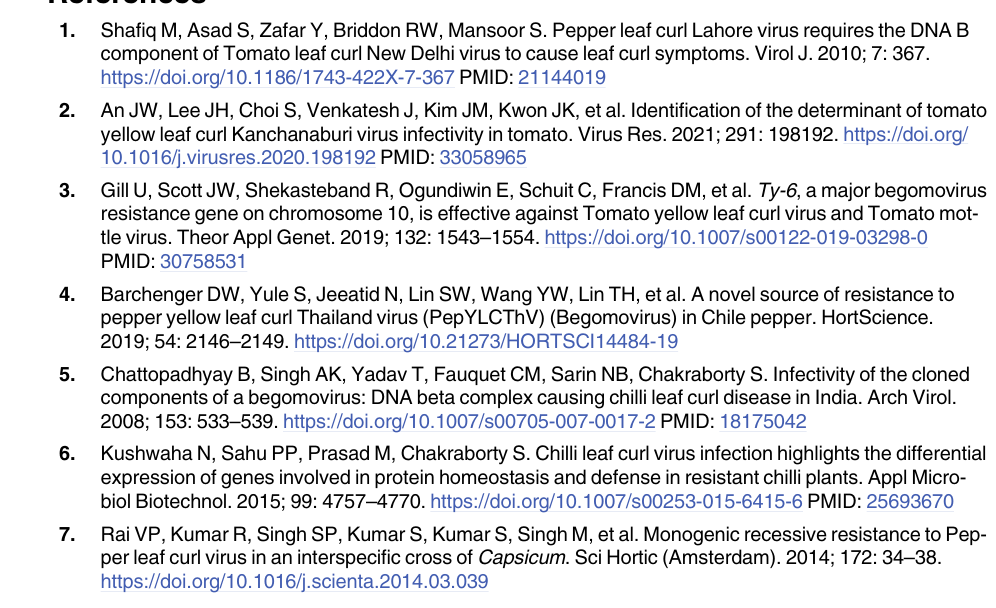
S3 Table. Marker validation using an additional F S4 Table. Intergenic SNPs in QTL